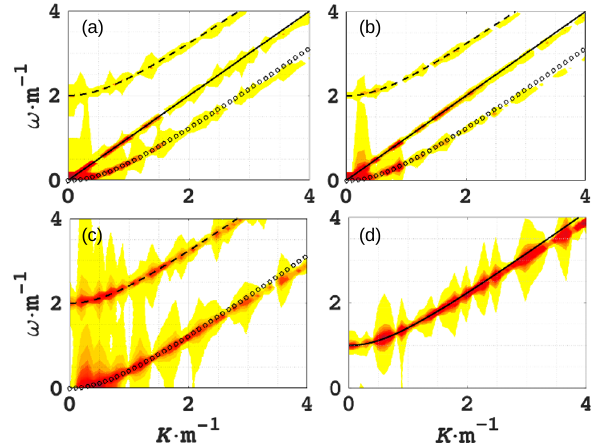
Figure 3 . Numerical energy spectra (colour-filled contour plot) along k z axis obtained by a real- time LCFT simulation. (a)-(b) Energy spectra of E x and E y , where the light cone (solid line) is well traced by the analytical electromagnetic mode dispersion. Distinguished from the 0-spin scaler QED model, the existence of pair and Langmuir modes (dashed and circle lines) implies the field structures of these two modes are polarization hybrid. (c) Energy spectrum of E z , where the gapped pair mode (dashed line) and gapless Langmuir mode (circle line) are well traced by the analytical electrostatic mode dispersion. The energy gap 2 m is a threshold beyond which pair plasmas will be generated. (d) Energy spectrum of ψ 1 R . The weak self gauge field dressed bispinor spectrum is well traced by a free fermion dispersion (solid line). ( m = 0 . 25 , ∆ t = 0 . 5 , ∆ x i = 1 , N t = 512 , N x